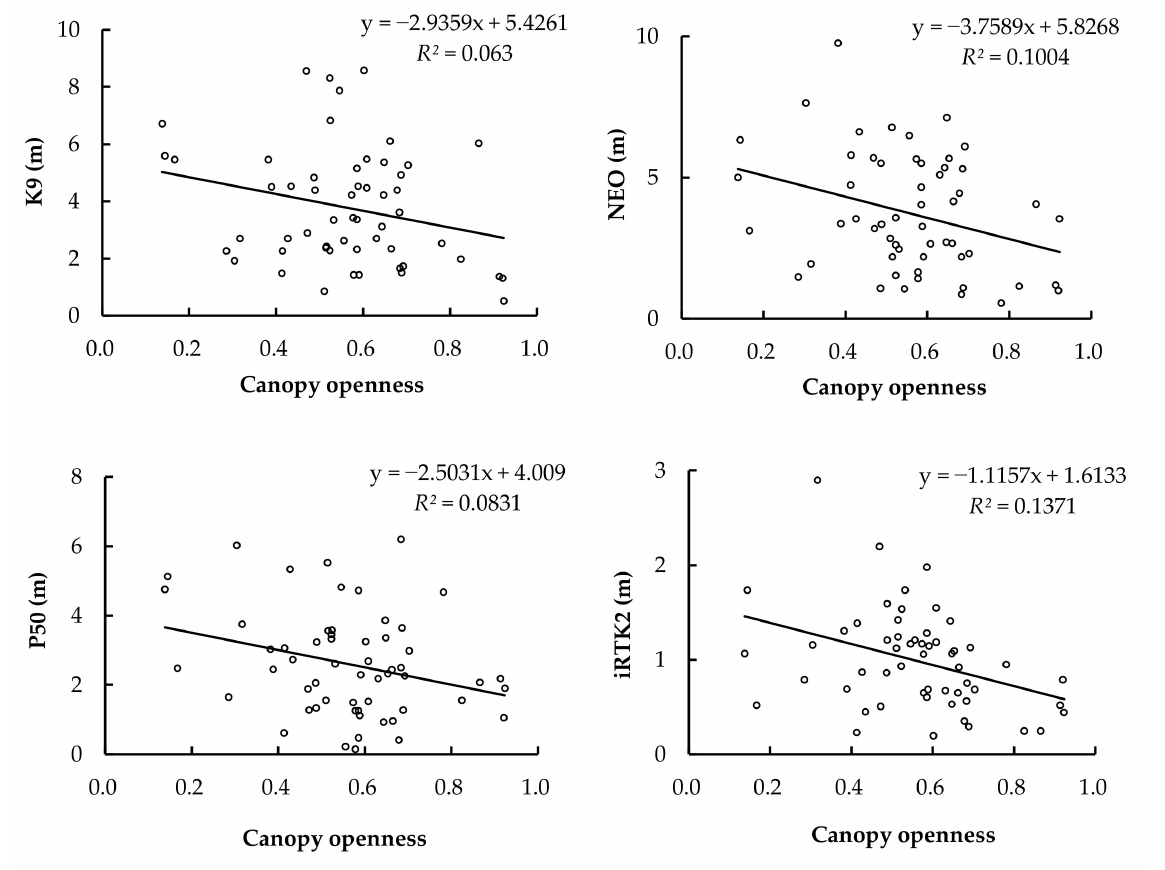
Figure 11. Horizontal DRMS of the PPP model under different